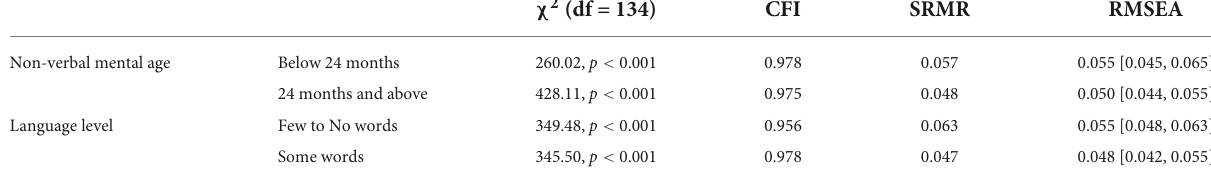
TABLE 3 Fit statistics of two-factor CFA models.